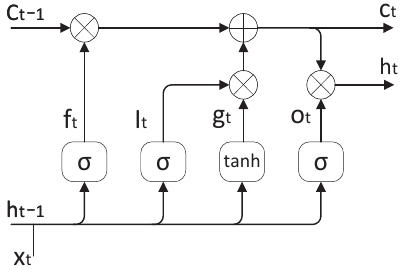
Figure 2. Schematic diagram of a basic LSTMs